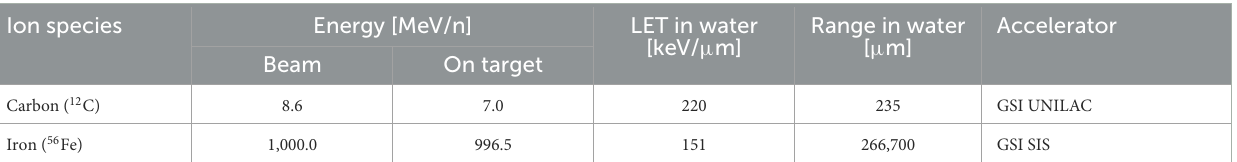
TABLE 2 Characteristics of heavy ion